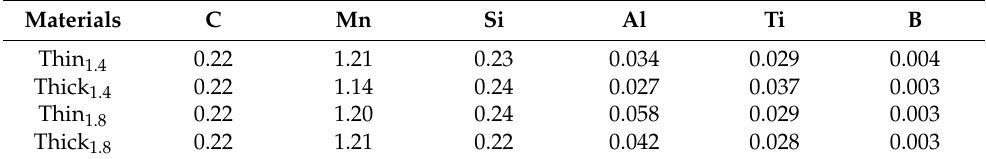
Table 1. Typical chemical composition of the Al–Si-coated 22MnB5 steels in this work (wt.%). C Mn Si Al Ti